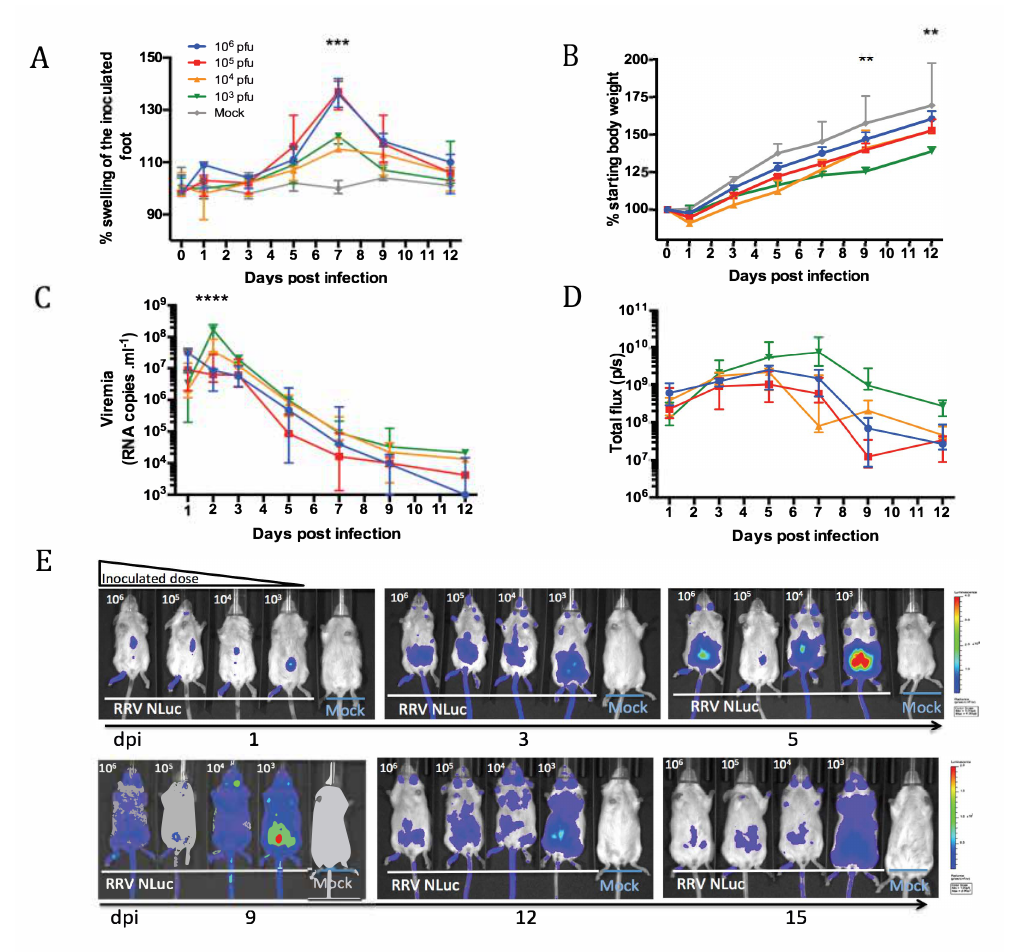
Figure 3. Dose-e ff ect on the in vivo dissemination of RRV-NLuc during the acute phase. Mice were infected with doses ranging from 10 3 to 10 6 pfu of RRV-NLuc (10 6 [blue]–10 5 [red]–10 4 [orange]–10 3 [Yellow]-Mock [grey]). Mice were monitored for the indicated parameters. Each data point is the mean ± SEM of five mice and is representative of two independent experiments. ( A ) % Swelling of the inoculated foot; ( B ) body weight gain (%) significant di ff erence observed at 9–12 dpi between the 10 3 pfu group and all the other tested doses; ( C ) viremia in peripheral blood, significant di ff erence observed at 2 dpi between the 10 3 pfu group and all the other tested doses; ( D ) quantification of the bioluminescent signal (whole body) and ( E ) longitudinal imaging of the bioluminescent signal within five animals from 1 to 15 dpi. From the right to the left, decreasing inoculated doses and mock mice (10 6 –10 5 –10 4 –10 3 - Mock), ventral side, scale upper panel (1–5 dpi) min = 5.10 6 max = 4.10 8 p / s / cm 2 / sr, scale lower panel (9–15 dpi) min = 1.10 5 max = 2.10 7 p / s / cm 2 / sr. (** = p < 0.01, *** = p < 0.001, **** = p < 0.0001, two